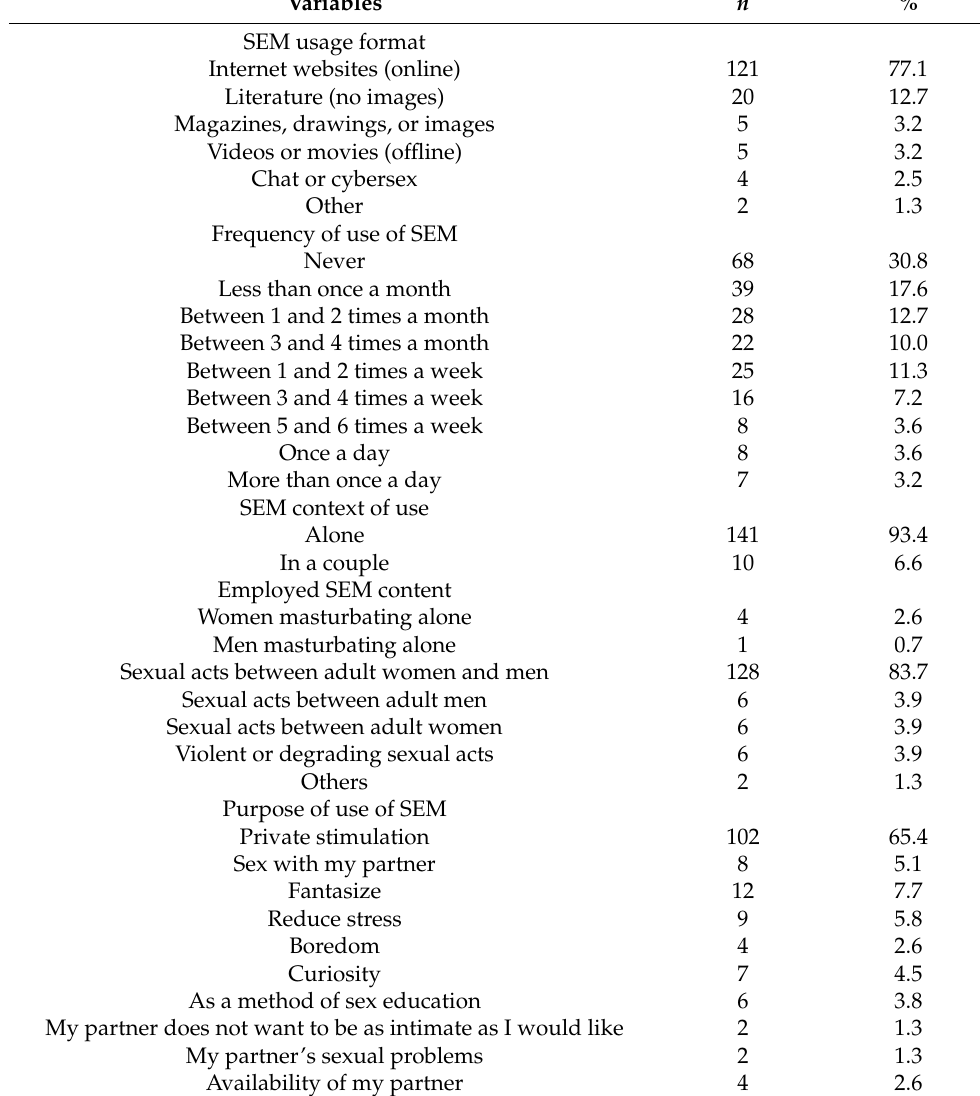
Table 2. Pattern of SEM